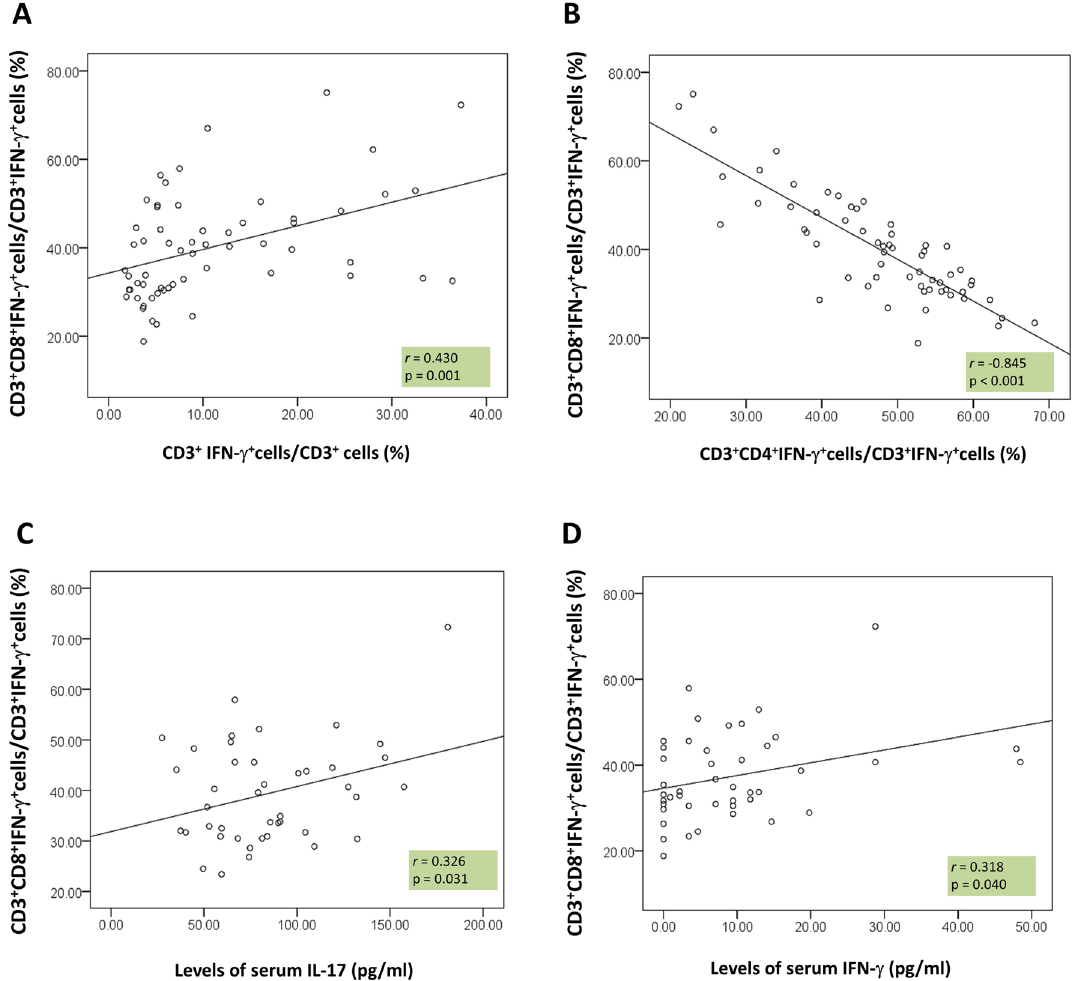
Figure 3. The relationship of CD3 + CD8 + IFN-γ + /CD3 + IFN-γ + ratio with other parameters. The CD3 + CD8 + IFN-γ + /CD3 + IFN-γ + ratio was positively correlated with ( A ) CD3 + IFN-γ + cells/ CD3 + cells ratio (r = 0.430, P = 0.001), ( C ) IL-17 level (r = 0.326, P = 0.031) and ( D ) serum IFN-γ level (r = 0.318, P = 0.040). The negative correlation between CD3 + CD8 + IFN-γ + /CD3 + IFN-γ + ratio and ( B ) CD3 + CD4 + IFN-γ + /CD3 + IFN-γ + ratio was found (r = − 0.845, P <